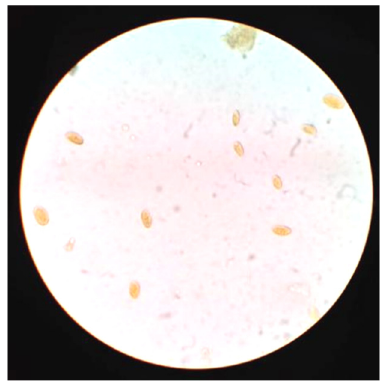
Figure 1. Giardia cysts stained with Lugol ′ s iodine under microscope (40×).